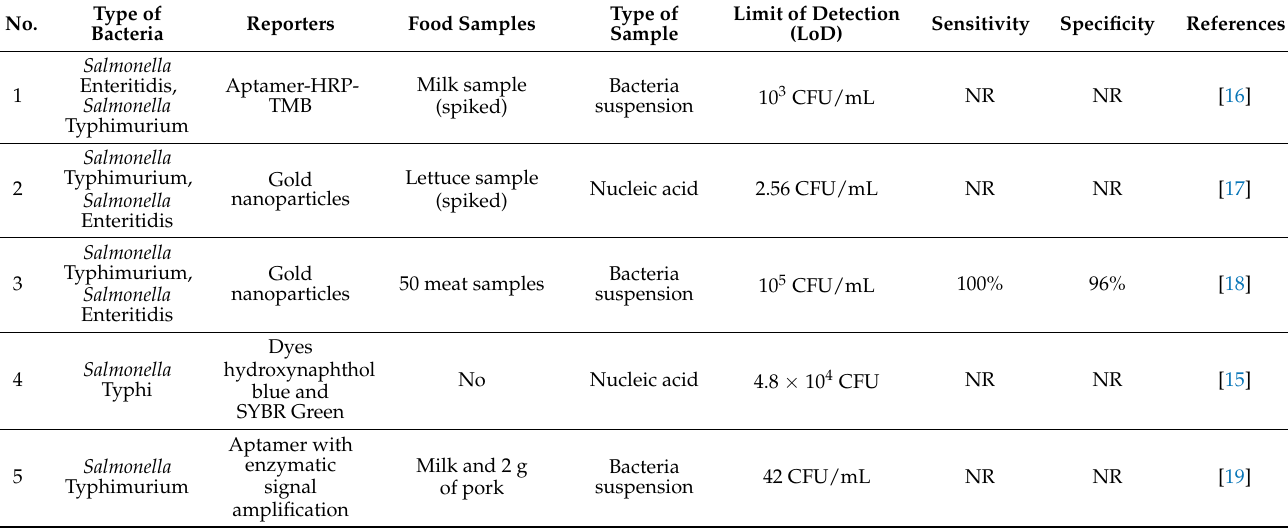
Figure 1. Study flow diagram during the selection process. n: number of studies. Table 1. Summary of the studies included.